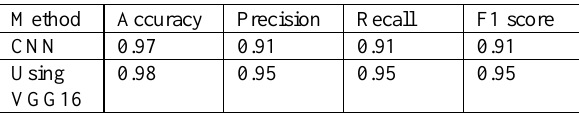
Figure 12. Confusion matrix for CNN model for malware classification using VGG16 as features extractor connected with optimised classifier for 25 families of malwares.